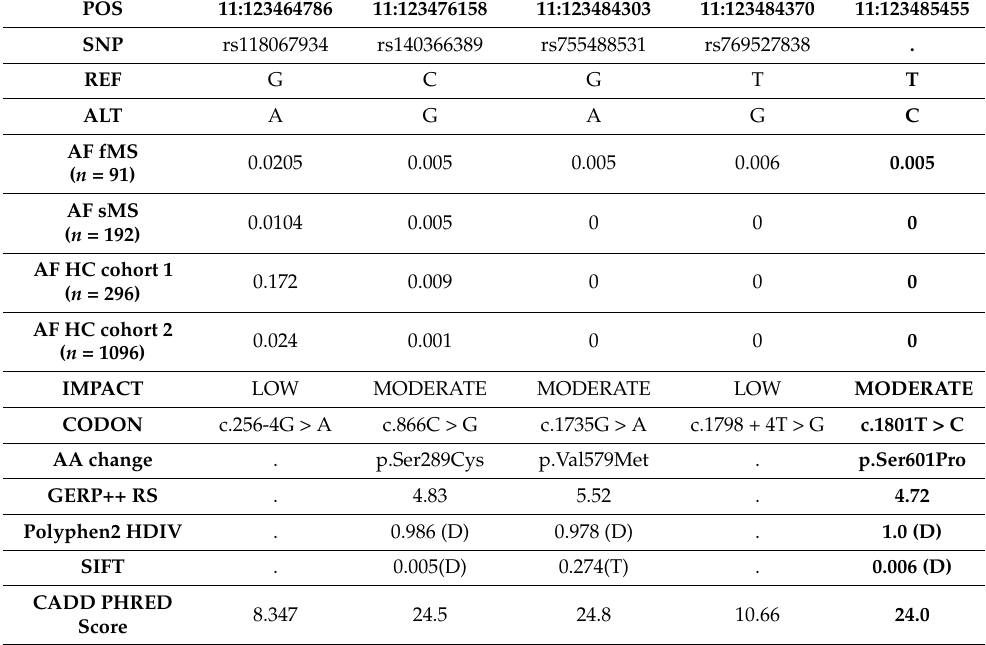
Table 2. List of rare and novel GRAMD1B variants identified in MS cases. For each variant, the frequency in familial (AF familial multiple sclerosis, n = 92) and sporadic multiple sclerosis (AF sporadic multiple sclerosis, n = 192) cases, in two cohorts of Italian healthy controls (the first using Sanger sequencing (AF HC cohort 1, n = 296) and the second using next-generation sequencing data from the Italian Reference Genome v1 (AF HC cohort 2, n = 1099)). Additional ions are